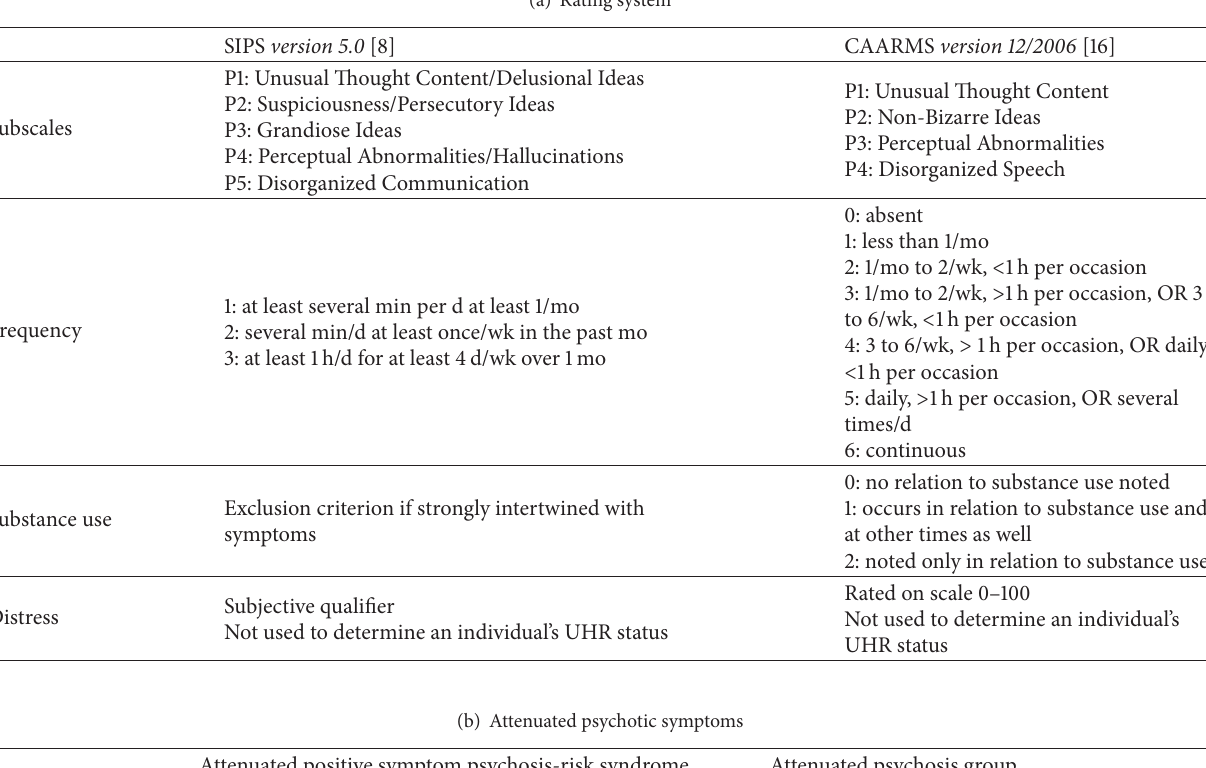
Table 1: UHR criteria: similarities and differences between the SIPS 5.0 and the CAARMS 12/2006 (see also eTable 1 for details on the psychopathological dimensions investigated by P1–P5 and